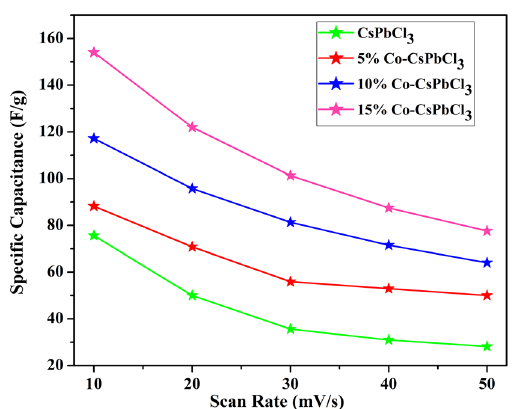
Figure 11. Specific capacitance of CsPbCl 3 and Co:CsPbCl 3